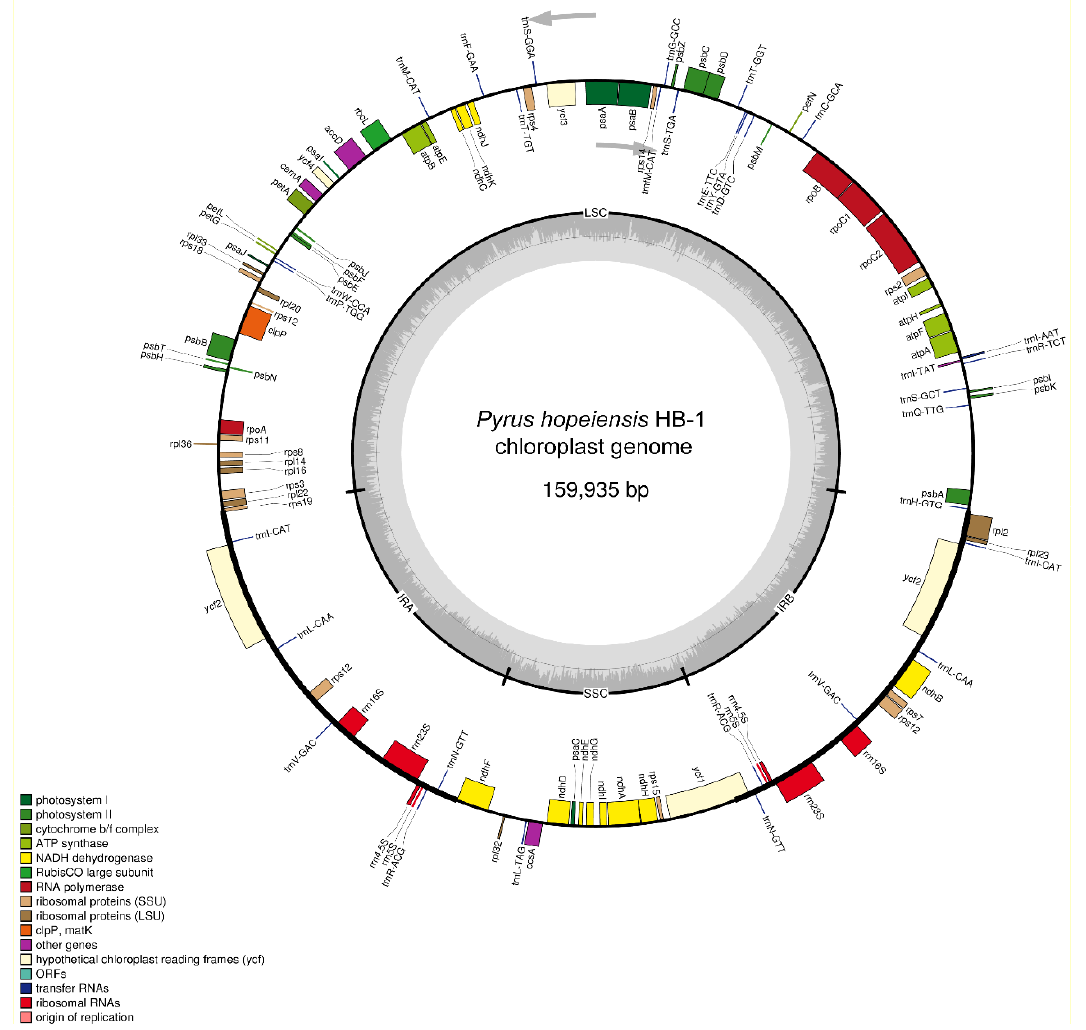
Figure 1. Gene maps of Pyrus hopeiensis HB-1chloroplast genomes.